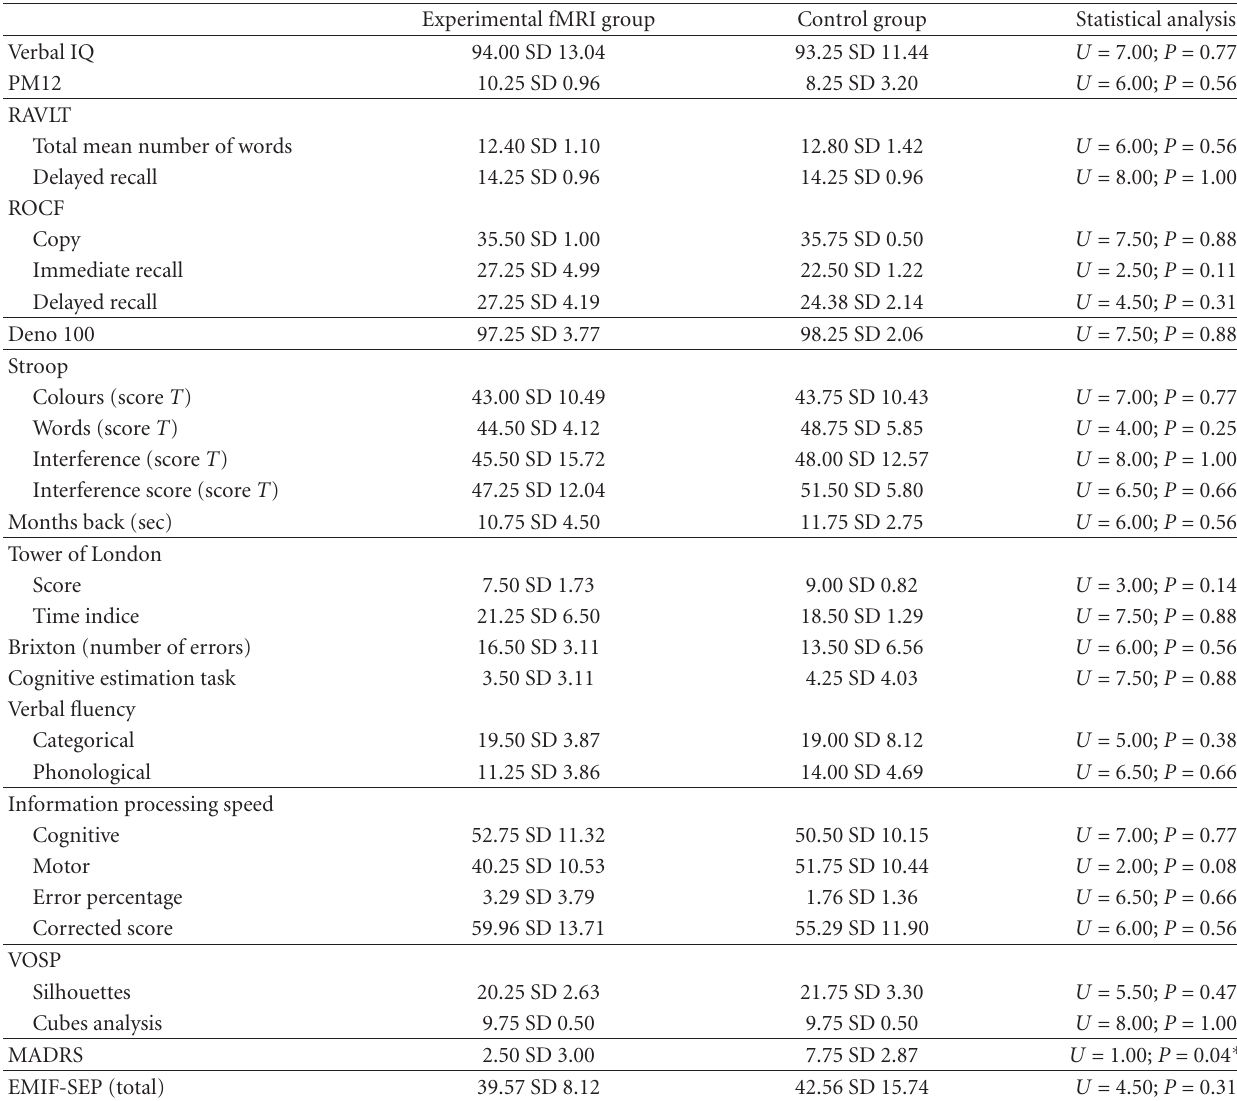
Table 2: Scores (mean and SD) for all MS patients by group for the neuropsychological baseline